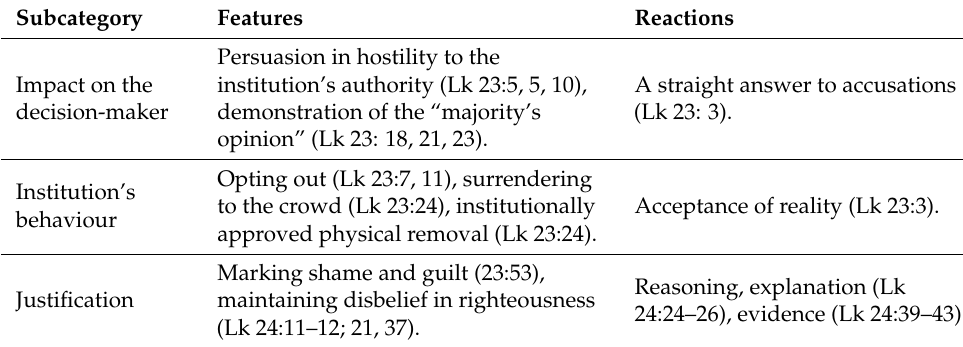
Table 7. Features of actions legitimising the victim’s